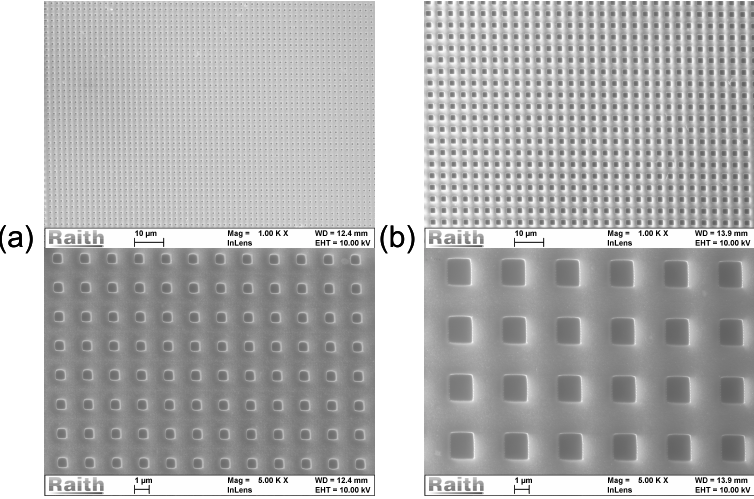
Figure 1. Scanning electronic microscope (SEM) micrographs of electron beam lithography fabricated arrays of ( a ) 1 µm and ( b ) 2 µm square pits at different magnification scales. Table 1. SF 6 reactive ion etching conditions.